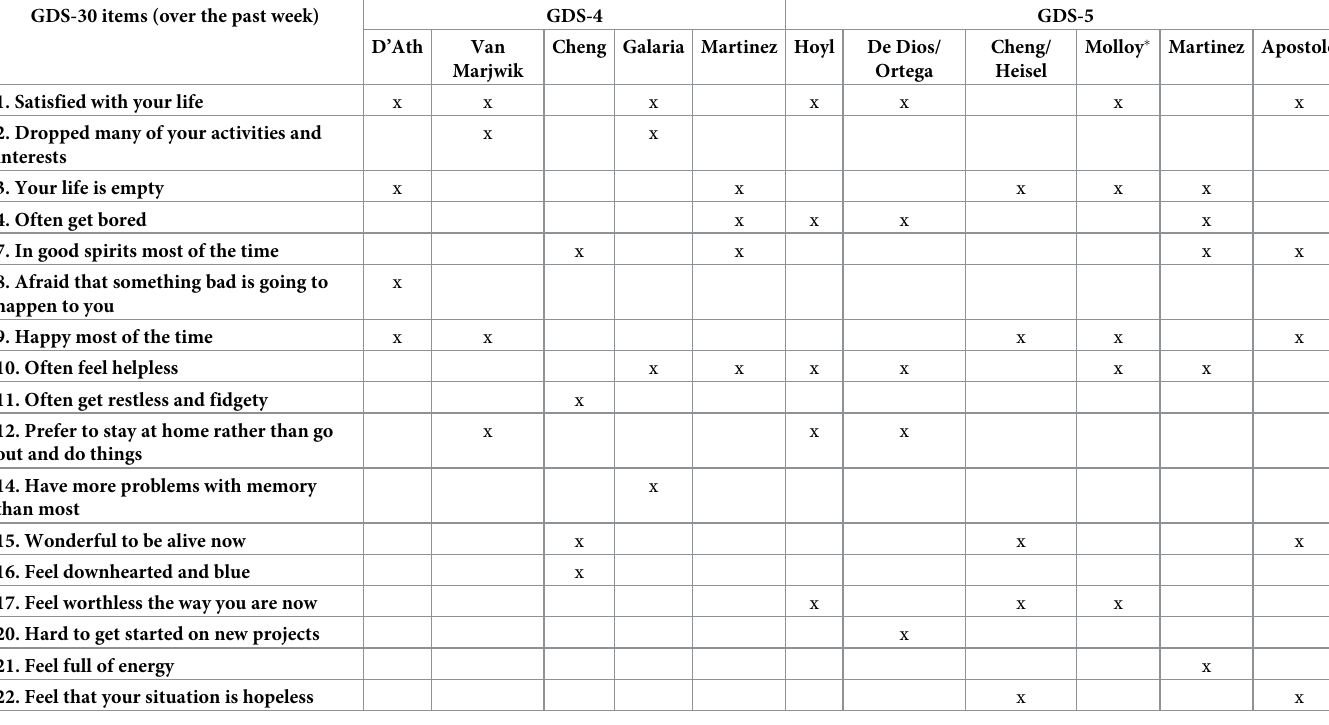
Table 2. List of items of each GDS-4 and GDS-5 version found in the included studies. GDS-30 items (over the past